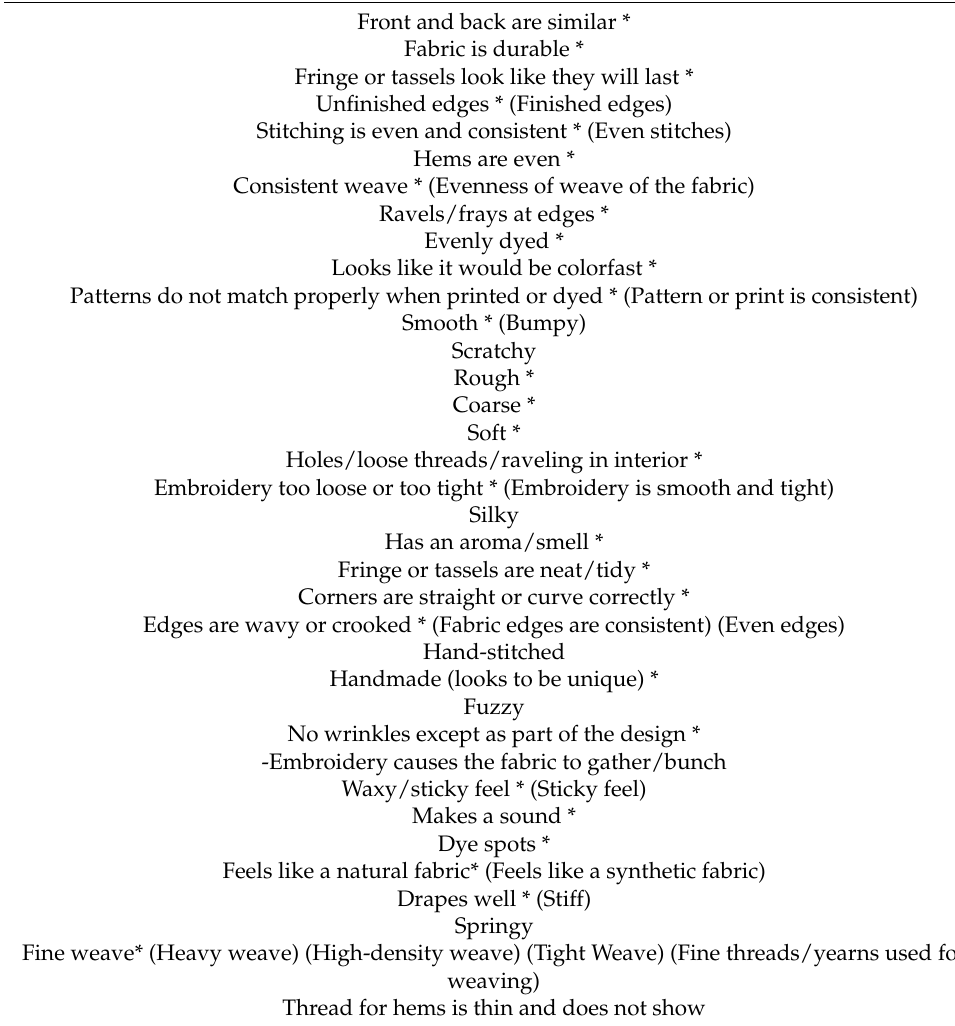
Table 4. Shortlist of 52 initial quality statements and 30 final (*) statements for textiles following first and final review by